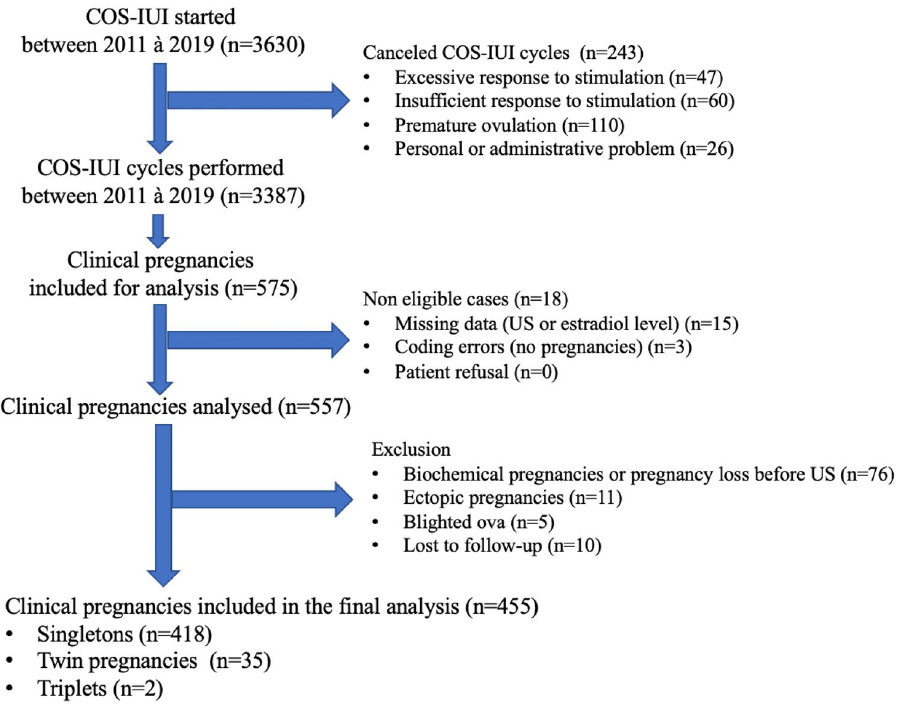
Figure 1. Study flow